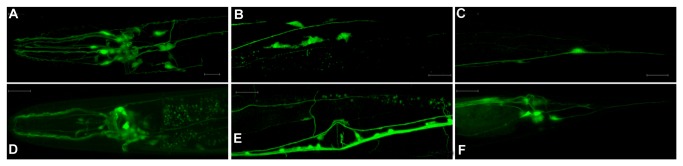
Confocal fluorescent images showing the expression pattern of the KCNL-2 promoter-GFP constructs.A–C. p
kcnl-2(atg1)
gfp is expressed in neurons of the head and NR (A), the vulval muscles (B), and tail ganglia (C) (strain vk1323). D–F. p
kcnl-2(atg2)
gfp is expressed in head neurons and NR (D); VNC, VC4 & VC5, and DC (E); and tail ganglia (F) (strain vk1327).